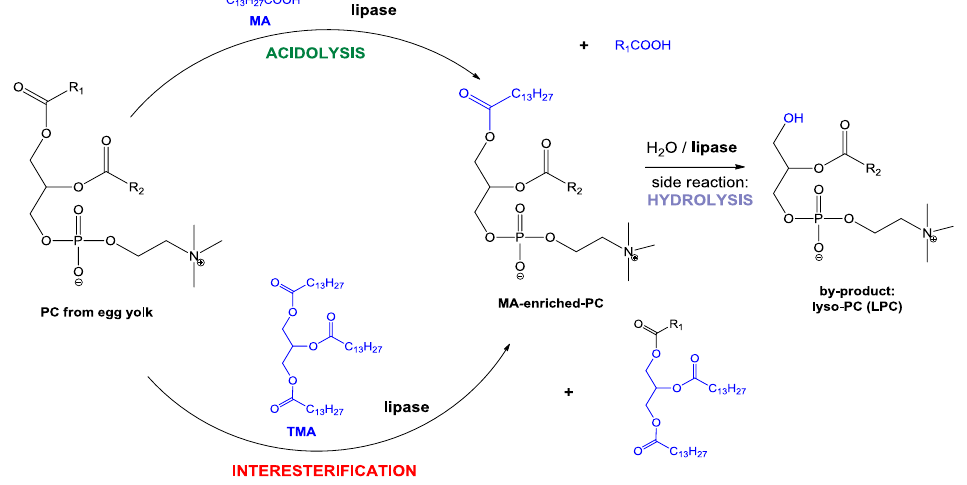
Table 1. Fatty acid (FA) composition (wt%) of substrates used in lipase-catalyzed transesterifications of egg-yolk phosphatidylcholine (PC) with trimyristin (TMA) and myristic acid (MA). FA TMA